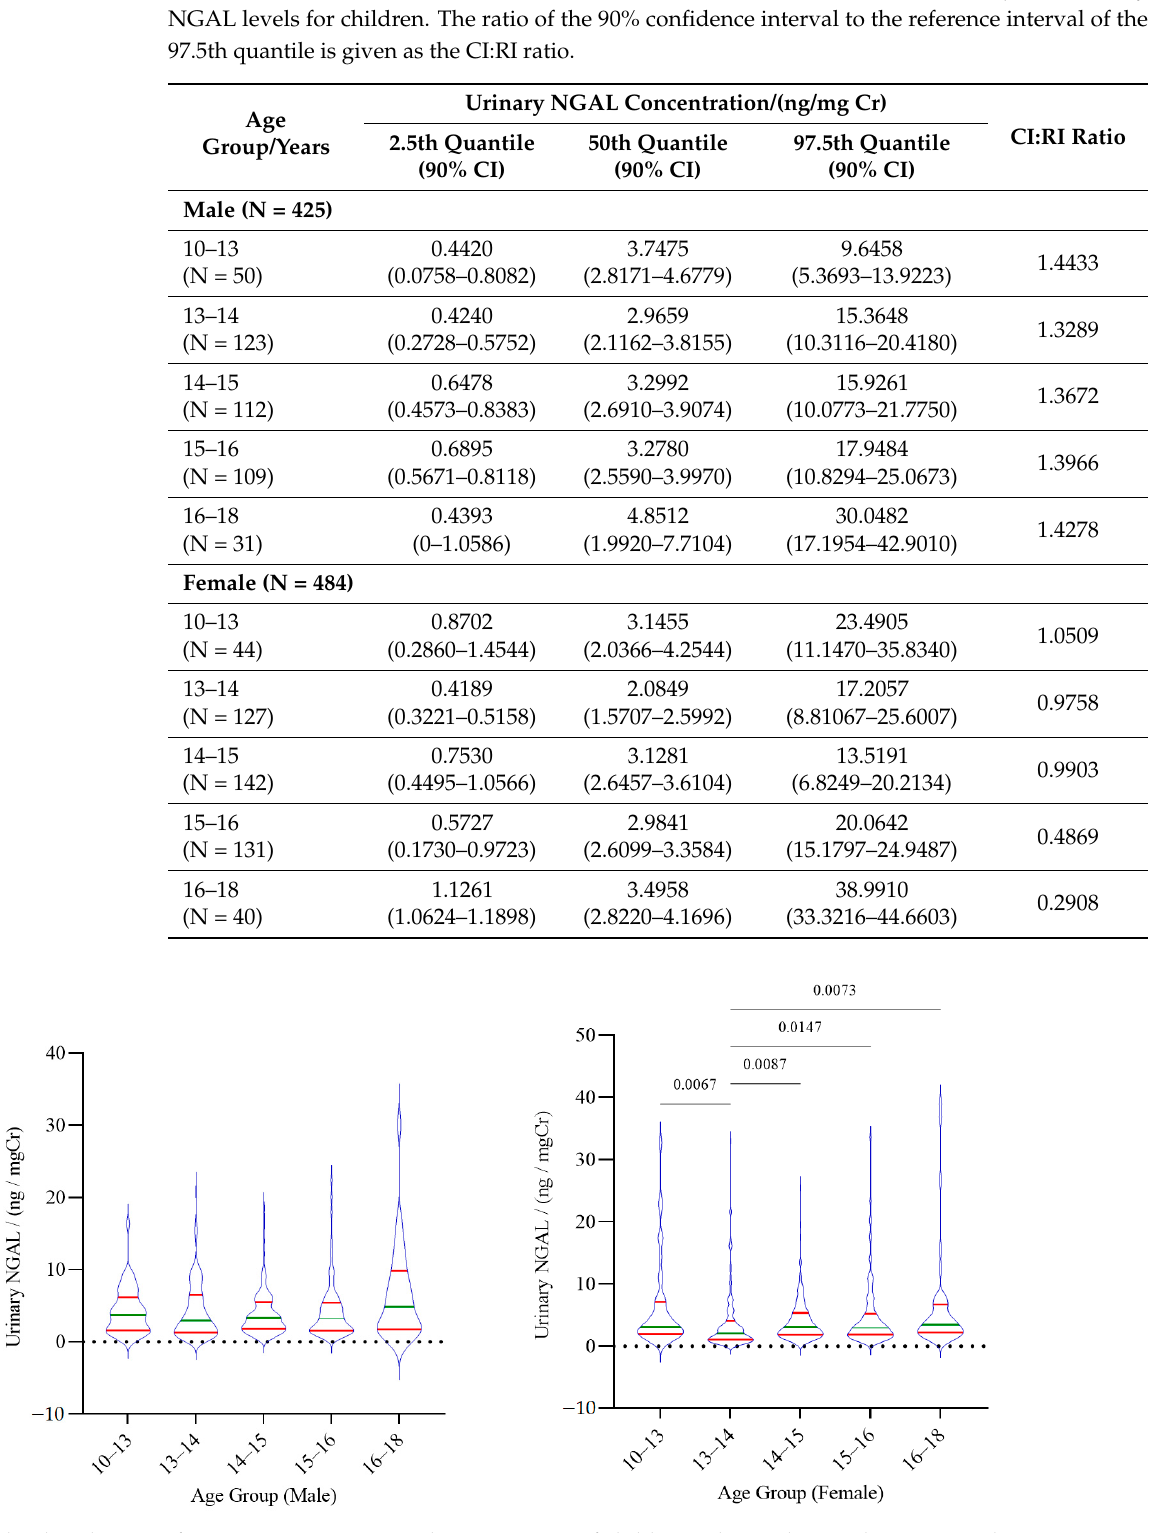
Figure 2. The distribution of urinary NGAL among the age groups of children. The median and inter-quartile range is shown for each group. Statistical significance is shown in adherence to Kruskal–Wallis one-way analysis followed by Dunn’s multiple comparison test.